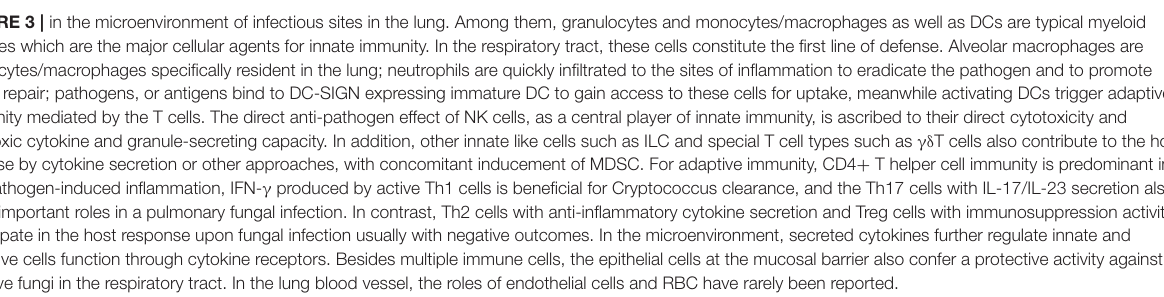
DCs also coordinate adaptive immune responses to